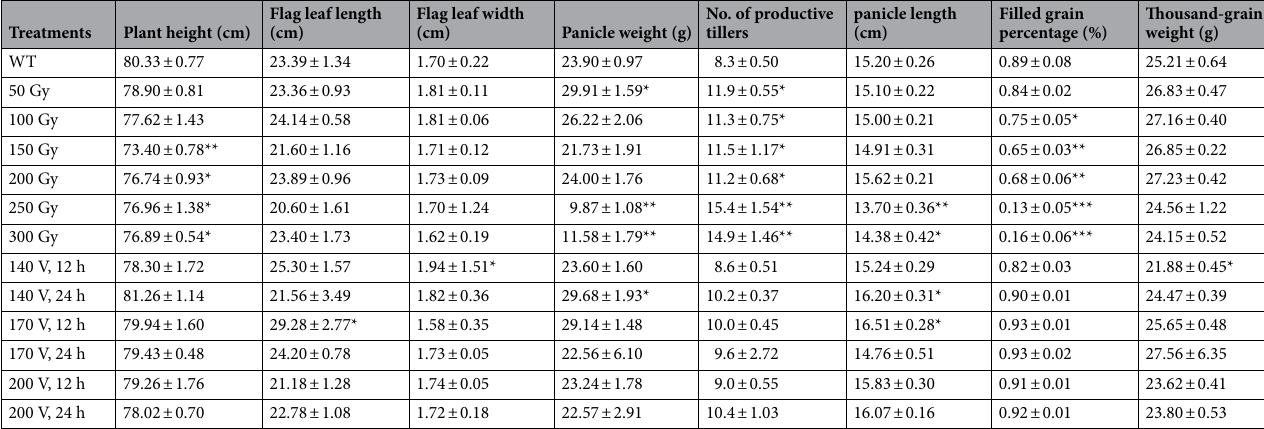
Table 4. Effects of γ-irradiation and DC electrophoresis bath mutagenesis on major agronomic traits. Data are expressed as mean ± S.E. * p < 0.05, ** p < 0.01, and *** p < 0.001.